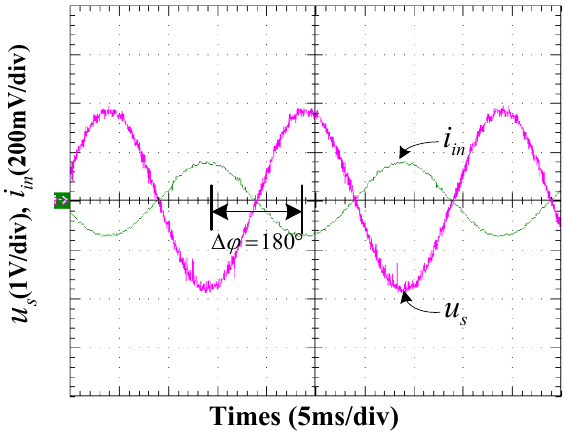
Figure 16. The voltage and current in grid-connected